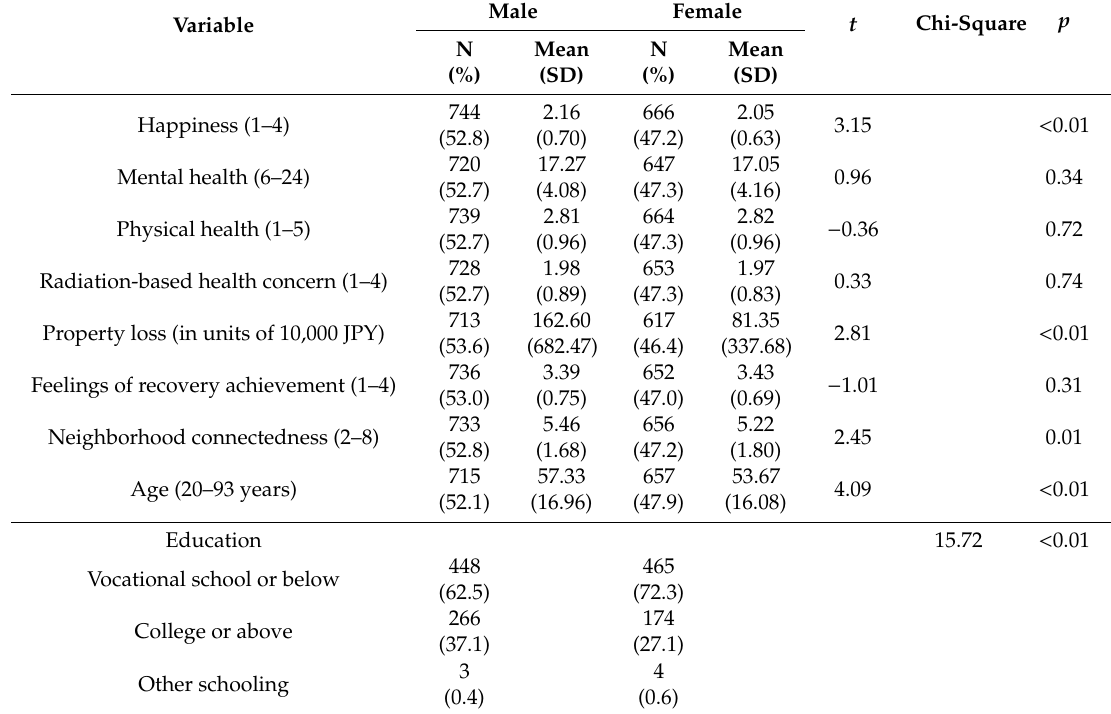
Table 1. Descriptive statistical results of the original